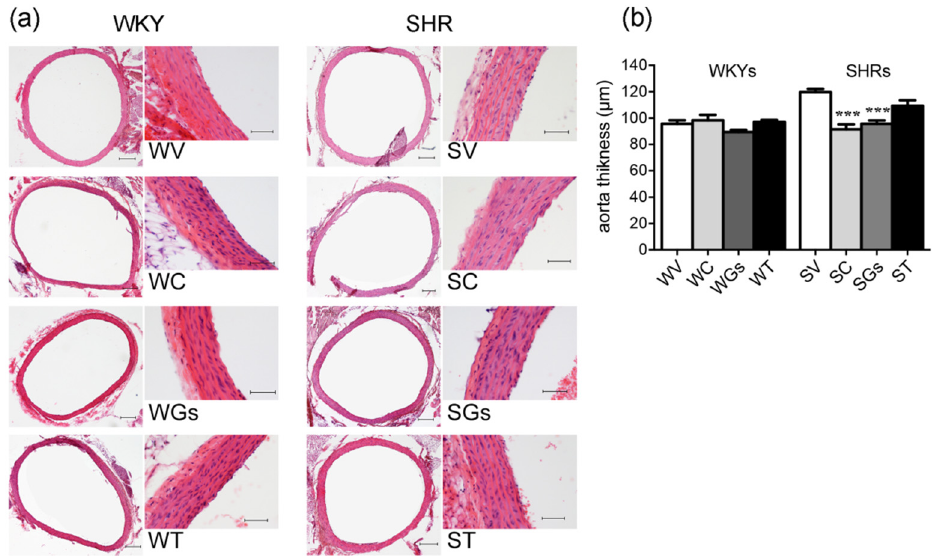
Figure 4. Histological evaluation of aorta wall thickness. Aorta samples obtained after administration